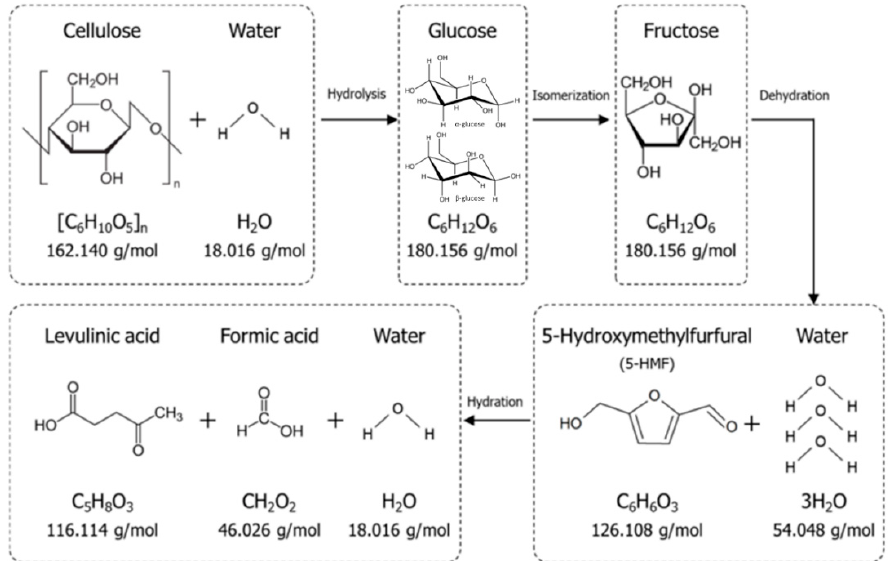
Figure 2. Consecutive reactions in the conversion of lignocellulosic biomass to levulinic acid. Adapted with permission from MDPI [63].